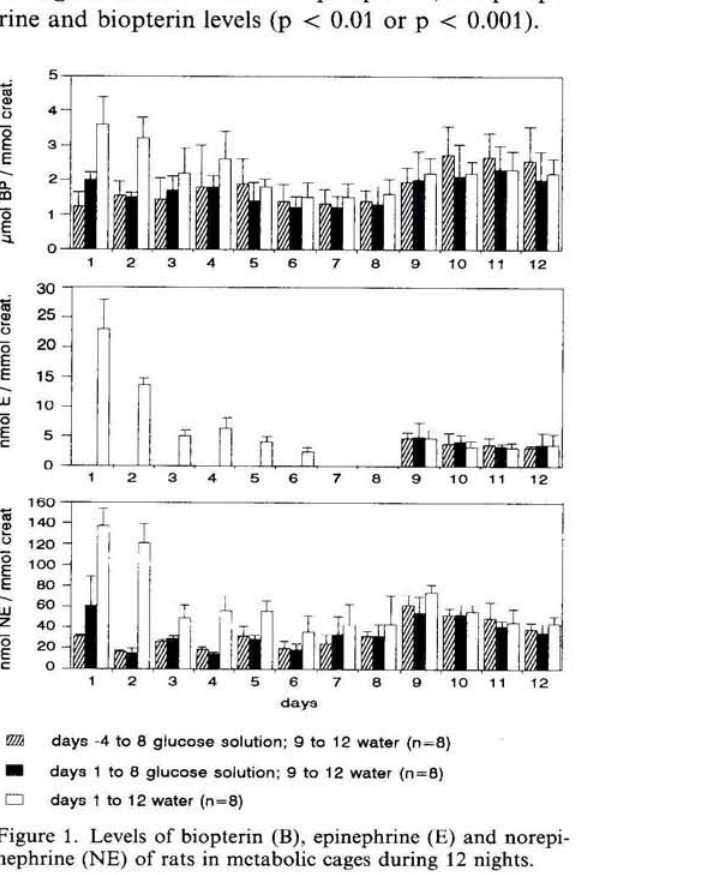
Figure 1. Levels of biopterin (B), epinephrine (E) and norepi- nephrine (NE) of rats in metabolic cages during 12